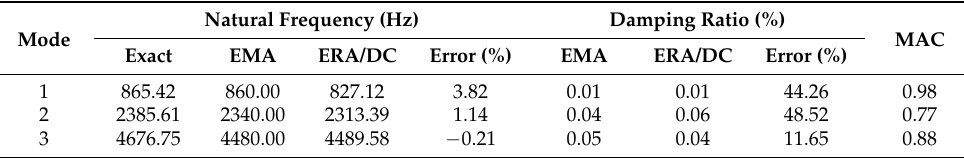
Table 6. Modal parameter identification result of free beam experiment.